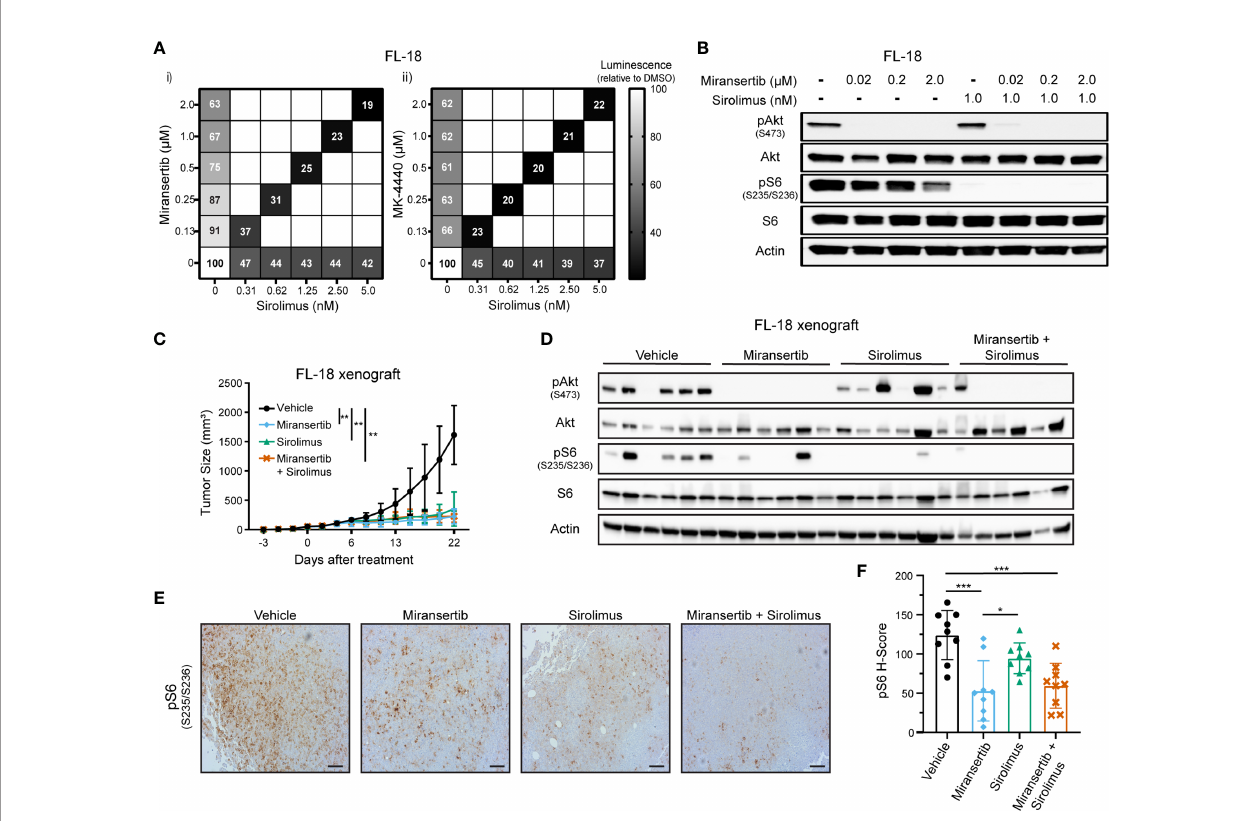
FIGURE 2 | Combined inhibition of Akt and mTORC1 strongly suppresses the growth of follicular lymphoma cells. (A) FL-18 cells were treated with different doses of sirolimus alone or in combination with miransertib (i) or MK-4440 (ii). After 72 h, the percentage of viable cells was calculated using CellTiter-Glo, normalized to the DMSO (vehicle; 100%) control, and the heat-map depicts the effect on cell viability. darker color = lower luminescence = lower viability. (B) FL-18 cells were treated for 3 h with miransertib, sirolimus, or the combination of both, and immunoblots performed as in Figure 1C . (C) FL-18 cells were subcutaneously (s.c.) injected into NOD-scid-gamma (NSG) mice and treated with vehicle (n=6), 100 mg/kg miransertib (n=6), 0.375 mg/kg sirolimus (n=6), and 100 mg/kg miransertib + 0.375 mg/kg sirolimus (n=6). The tumor growth was measured thrice per week, and the mean ± STD was illustrated in the line graph. **p < 0.01 determined by two-way ANOVA. (D) Immunoblots were performed on proteins extracted from the tumors collected at the end of the experiment shown in panel (C) . (E) Representative images of immunohistochemistry against pS6 (S235/6) performed to tumor sections. Sections were developed with DAB (3,3 ′ -diaminobenzidine) and counterstained with hematoxylin (Scale bars, 100 m m). (F) The histo H-score of pS6 was calculated from 9 frames per treatment group using HALO. *p < 0.05; ***p < 0.001 determined by one-way